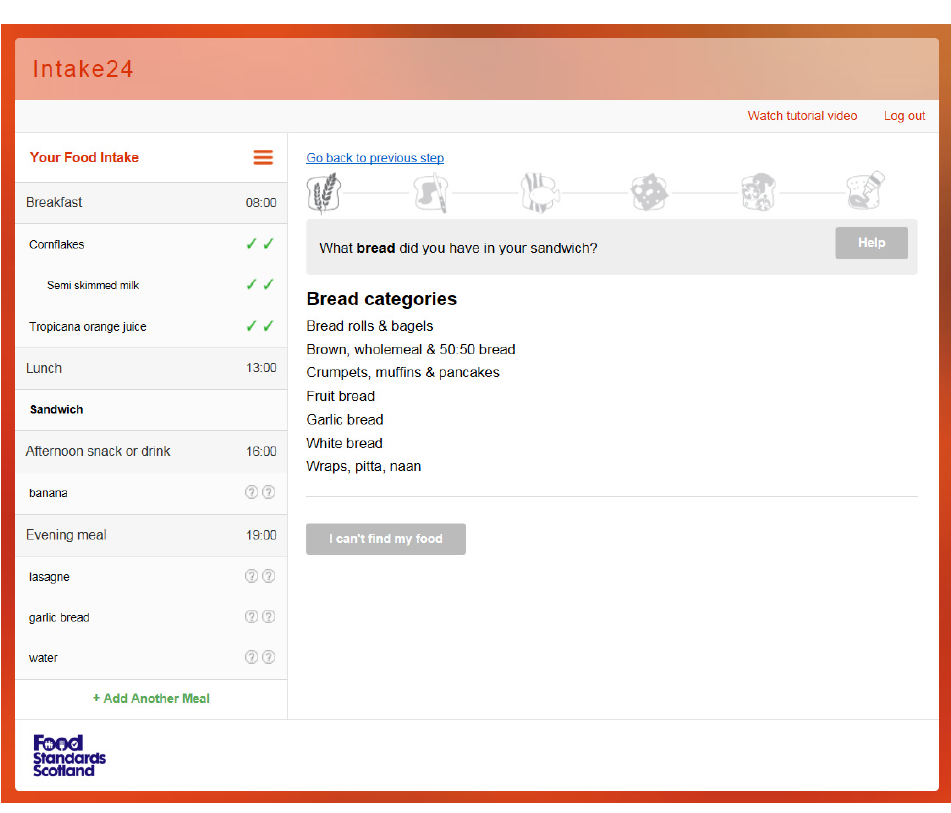
Figure 3. INTAKE 24 sandwich wizard. First stage; what bread did you have? Each of the greyed out icons represent the stages in the sandwich wizard.